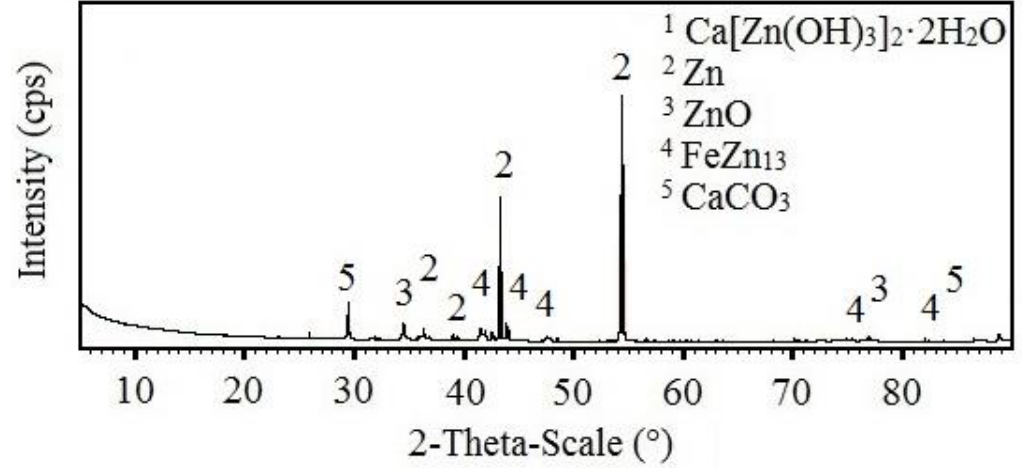
Figure 29. XRD analysis of HDG sample exposed for the duration of 3 months in simulated concrete pore solution of pH 12.8 with addition of MnO 4 − (Mn(3)).